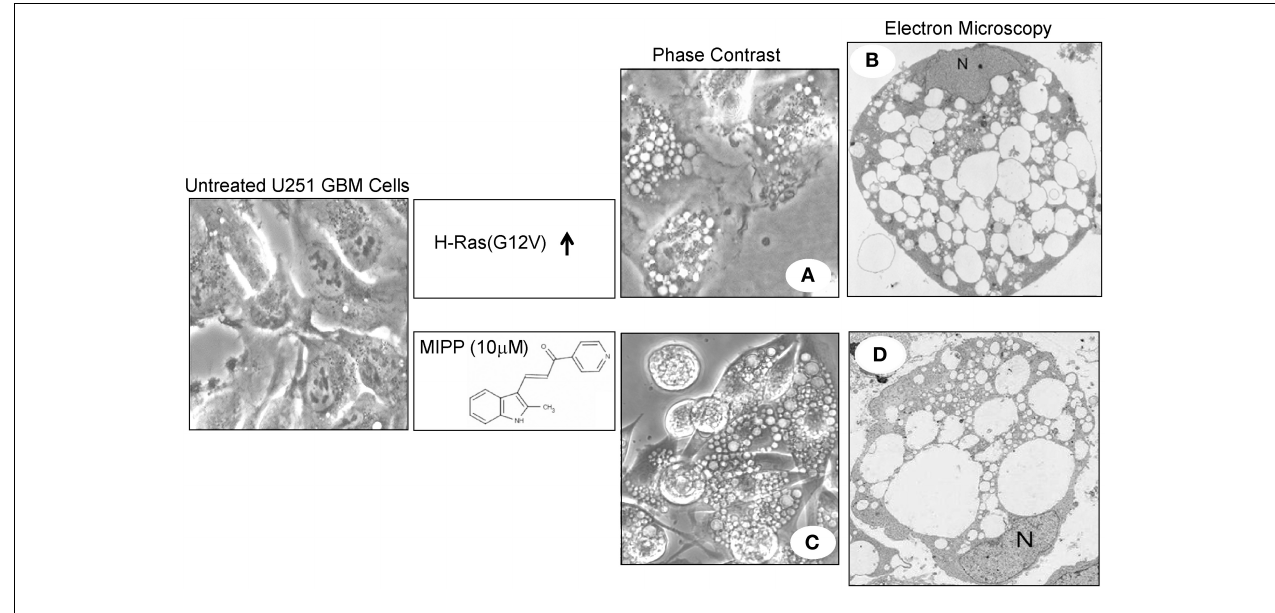
FIGURE 1 | Examples of extreme vacuolization of macropinosomes associated with non-apoptotic cell death (methuosis) in U251 glioblastoma cells. (A,B) Show phase contrast and electron microscopy images of a stable U251 cell line in which overexpression of H-Ras(G12V)